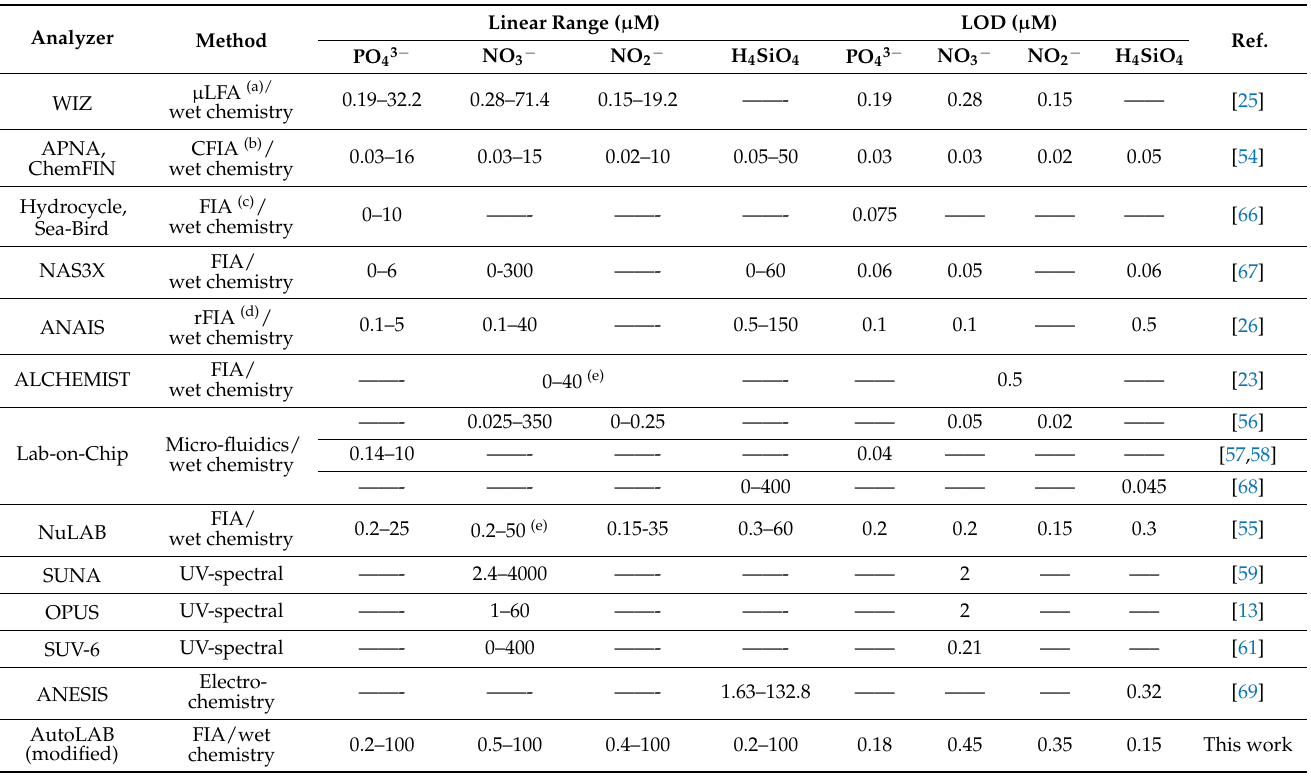
Table 1. Comparison of the AutoLAB (modified) and other available nutrient sensors reported in the literature and that are commercially